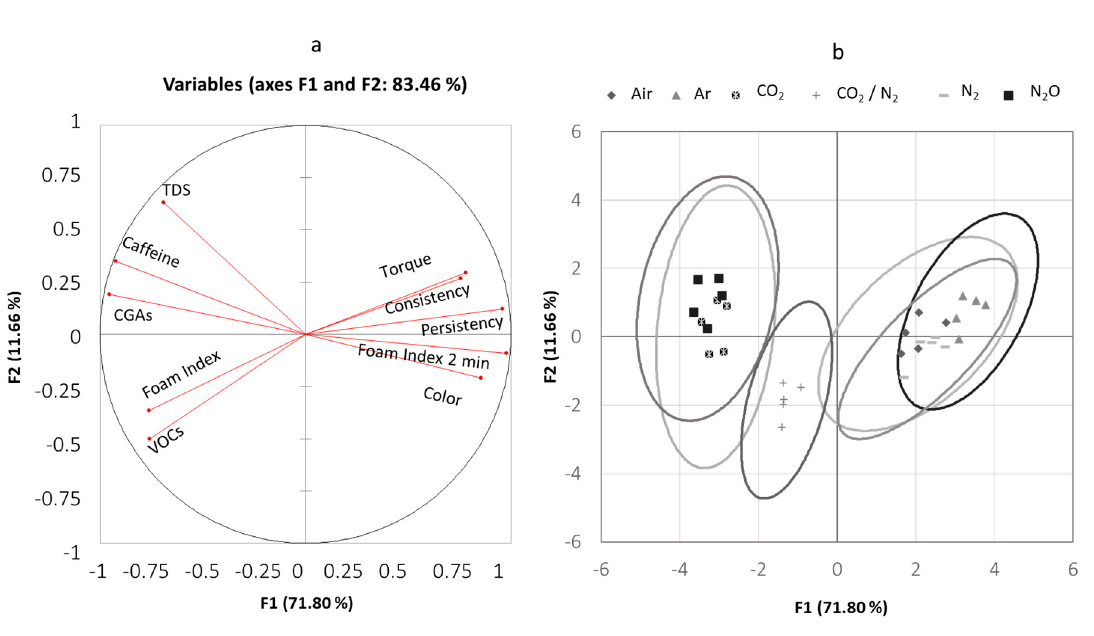
Figure 4. The first panel ( a ) represents the correlation between a variable and a principal component; the second panel, ( b ), represents the dispersion of factorial scores on the first and second axes. The angle between vectors is an approximation of the correlation between variables. A small angle indicates variables that are positively correlated, an angle of 90° indicates that they are not correlated, and an angle close to 180° indicates a negative correlation; see, for example, Color–Caffeine and CGA concentration, or CGA concentration and Foam Index after 2 min. The length of the line and its closeness to the circle indicates how well the variable is represented in the plot.